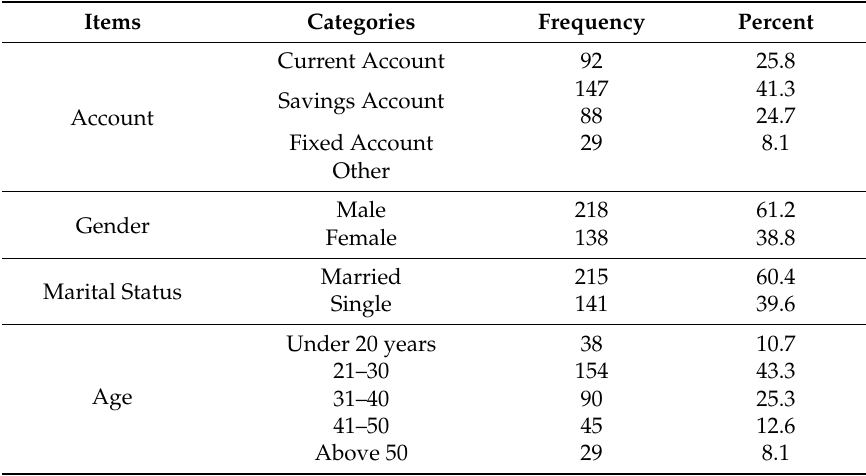
Table 2. Demographic information of